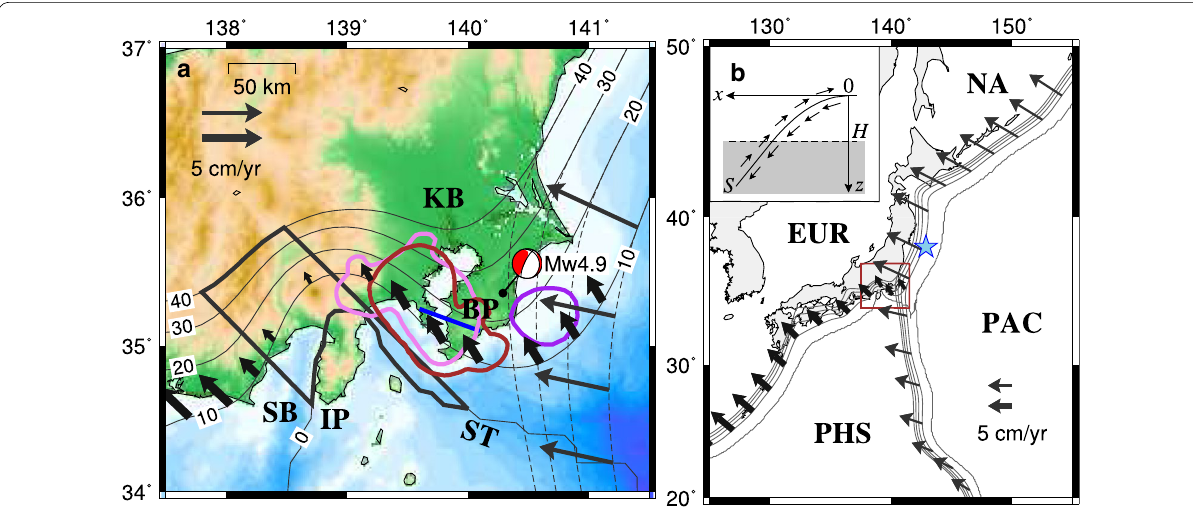
Fig. 1 a Landforms around Boso Peninsula (BP) and the Kanto Basin (KB). Topography data from Smith and Sandwell (1997). IP: Izu Peninsula, SB: Suruga Bay, ST: Sagami Trough. Solid contours map upper surface of PHS plate, and dashed contours, upper surface of PAC plate. Blue line indicates structural high bounding forearc basin and trench slope. Focal mechanism marks location of M w 4.9 normal-type earthquake of 2019/05/25. Thick black outline indicates best estimate of locked zone due to collision of the Izu-Bonin arc at Izu Peninsula (Hashima et al. 2016). Colored outlines show source/slip areas for 1703 Kanto earthquake (red) (Sato et al. 2016), 1923 Kanto earthquake (pink) (Matsu’ura et al. 2007), and Boso slow slip zone (purple) (Sato et al. 2017). b Slip rate distribution on plate interfaces around Japan used in our computations. Contours denote upper surfaces of PHS and PAC plates. Slip rates for PHS plate (thick arrow) and PAC plate (thin arrow) based on NUVEL-1A model (DeMets et al. 1994). 3-D plate interface data from CAMP model (Hashimoto et al. 2004). Star: hypocenter, 2011 M9 Tohoku earthquake. Red rectangle indicates area shown in a . Inset: Schematic illustration of internal structure and slip distribution in vertical section perpendicular to the trench. See text for parameter H and